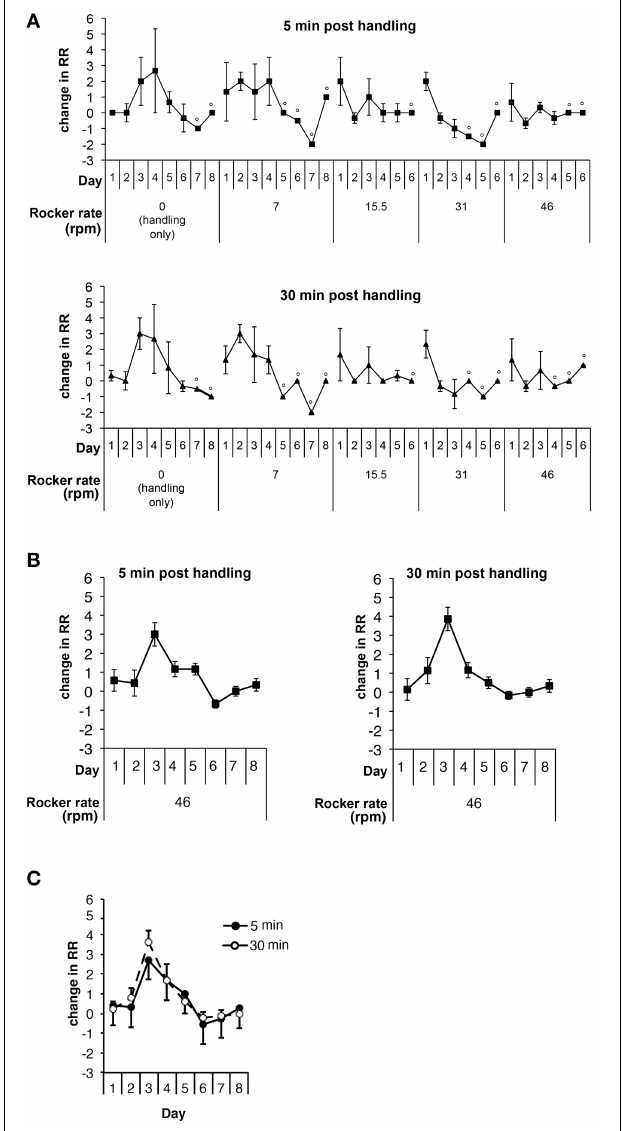
FIGURE 3 | The change in respiratory rate (RR) of (A) group 2 AGS ( n = 3) and (B) group 3 AGS ( n = 7) at 5 or 30min after handling with or without movement compared to before exposure as measured in breaths per minute. Rocker rate in rotations per minute (rpm) or without rocking motion (0rpm, handling only). Change in RR are shown as mean ± s.e.m. One trial was performed per day. “ O ” less than 3 AGS were tested at these times since one or more AGS had progressed to the next level of movement and therefore no error bars are reported. (C) Changes in RR in animals from group 2 exposed to handing only and group 3 at 5 or 30min after handling were averaged ( n = 10 AGS), data are presented as mean ± s.e.m. A linear-mixed effects model analysis was performed on data shown in (C)